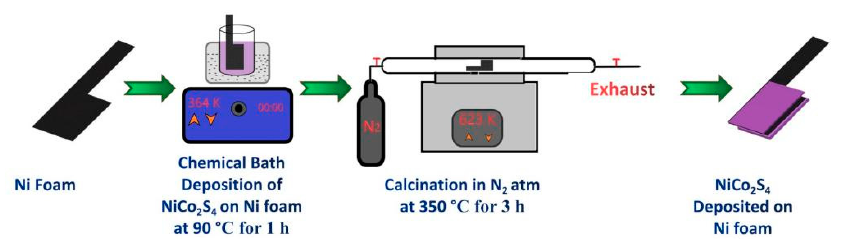
Figure 2. The chemical bath deposition process.